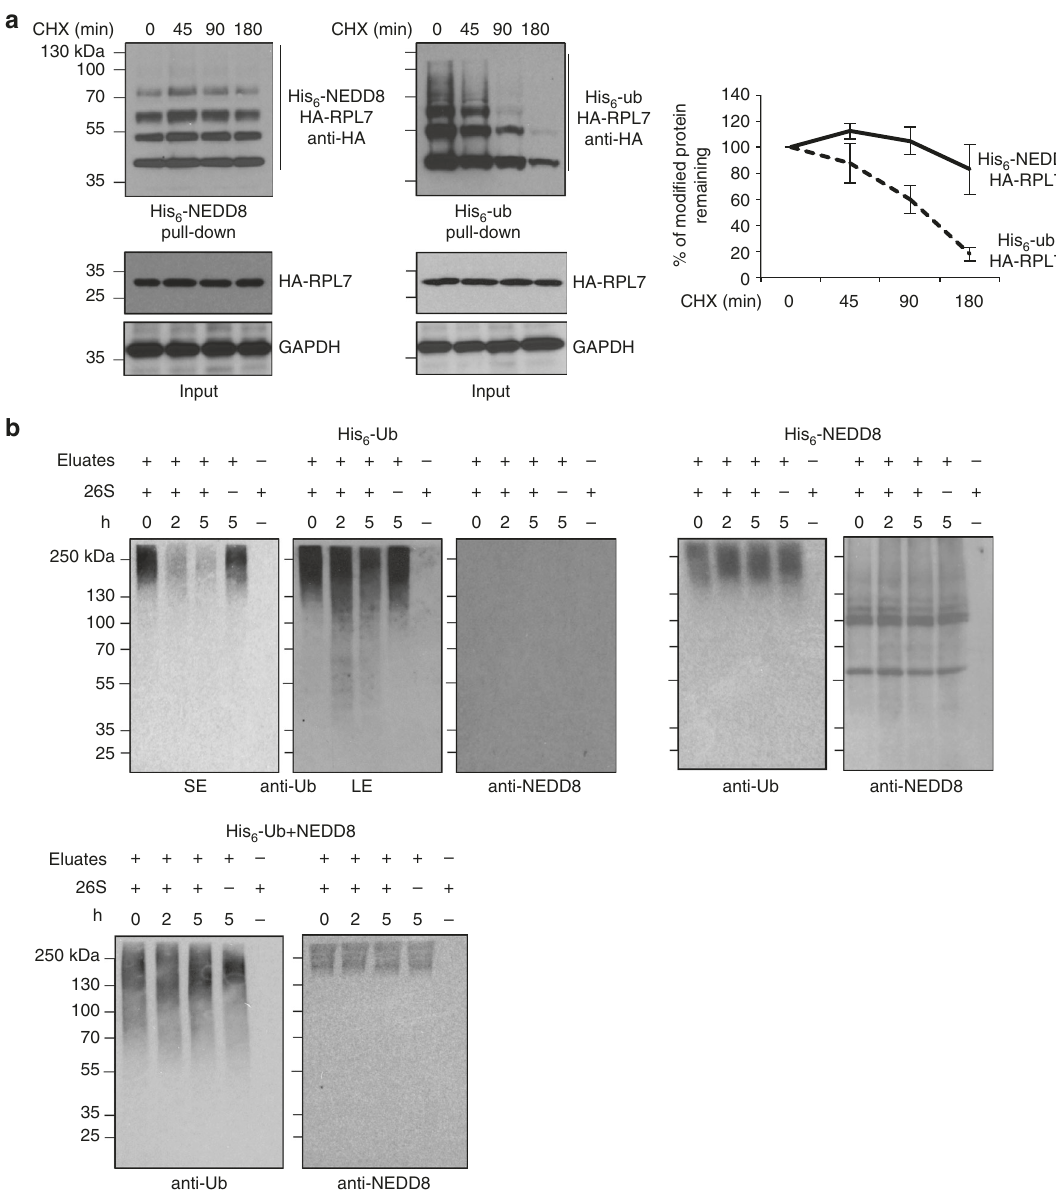
were performed in 96-well plates for a period of 30min. The proteasome inhibitor MG132 was used to measure any nonproteasome protease activity and was sub- tracted from the data.